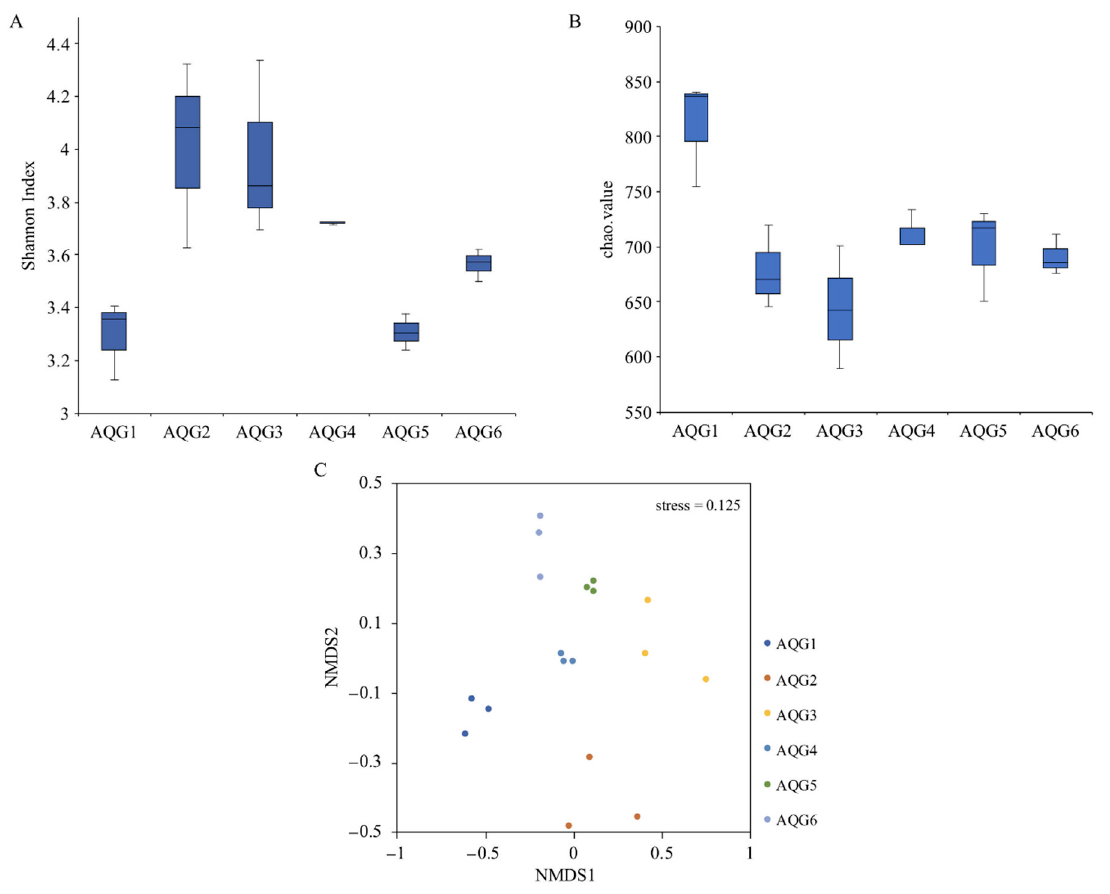
Figure 4. ( A , B ) Alpha diversity of microbial communities in the six rock layers in the Aiqigou (AQG) mud volcano. Each value indicates 3 replicates values and error bars represent standard deviations. ( C ) Non-metric multidimensional scaling analysis describing the microbial community structure of each layer is presented along two major dimension-reduced axes based on Bray-Curtis distance. (Stress < 0.2, non-metric multidimensional scaling (NMDS) can accurately reflect the degree of difference between